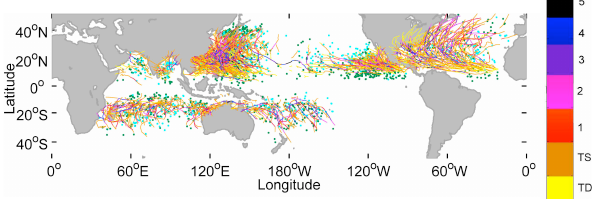
Figure A1. Tracks of tropical cyclones from January 2004 to De- cember 2012, associated with the distribution of Argo pairs used in the paper. The colors of the tracks indicate the categories of tropical cyclone–tropical depression (TD; yellow), tropical storm (TS; or- ange), and category 1–5 cyclones (denoted by red, magenta, purple, blue, and black from categories 1 to 5, respectively). The locations of Argo pairs are dotted in two colors: cyan dots are the pairs lo- cated at the right side of the corresponding TC track, and green dots are the pairs located on the left side of the track. We analyze 885 tracks and a total of 4410 Argo